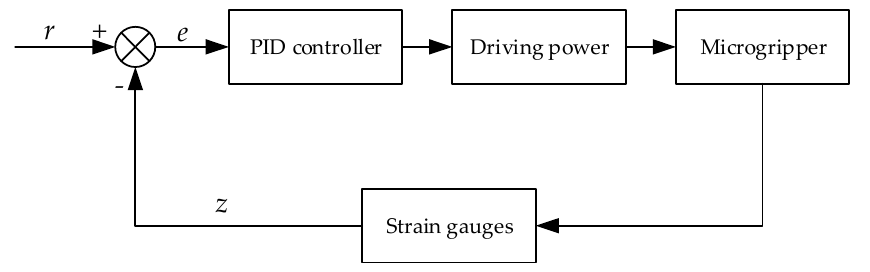
Figure 8. The schematic diagram of the closed ‐ loop control.